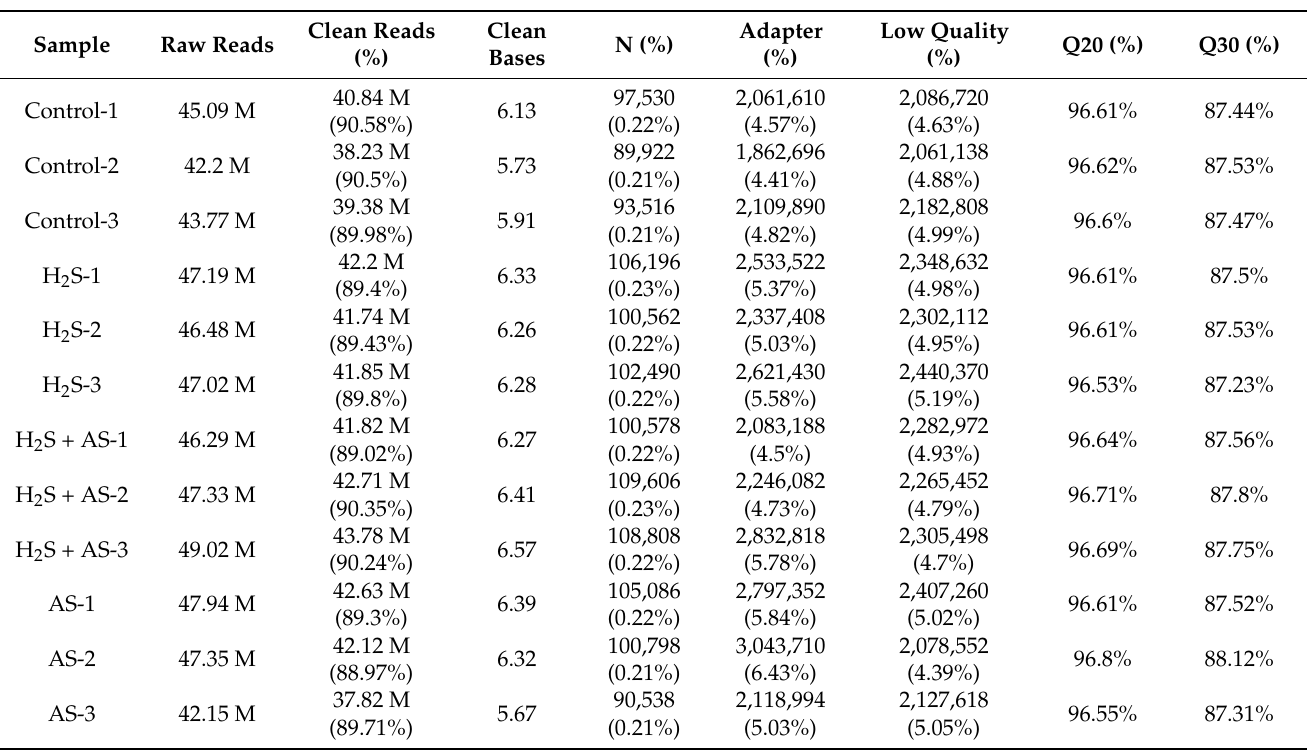
Table 1. Summary of the RNA-seq data collected from H 2 S and alkaline salt stress roots of M. hupehensis